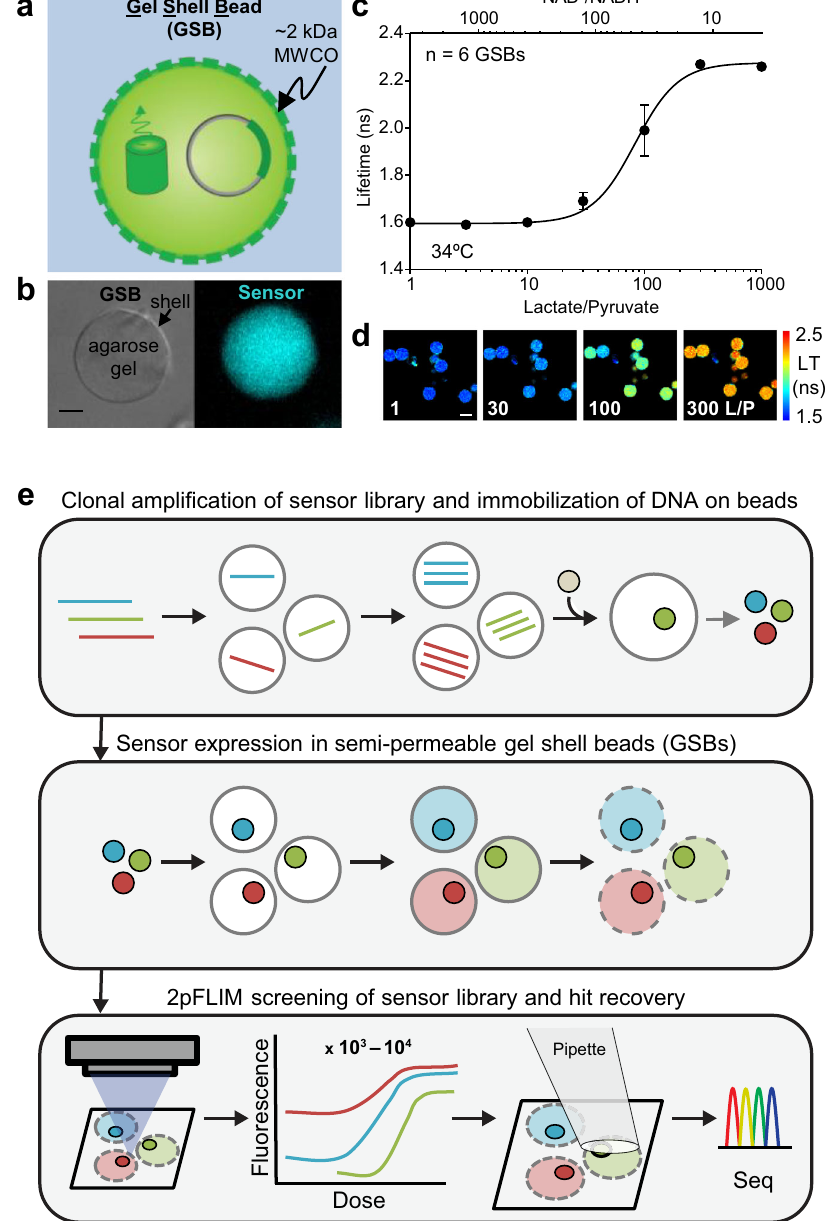
Fig. 1 GSBs as a platform for screening genetically encoded fl uorescent biosensors. a Cartoon depiction of a GSB containing plasmid DNA and fl uorescent biosensor protein. An agarose gel core is wrapped in a polyelectrolyte shell with a reported molecular weight cutoff of ~2kDa 17 . b A single 20 μ m GSB doped with a green fl uorescent biosensor, bright fi eld ( left ) and epi fl uorescence ( right ), 5 μ m scale bar. c Dose response curve of Peredox, a fl uorescence lifetime sensor that responds to NAD + /NADH 1,47 , acquired at pH 7.3 at 34°C on puri fi ed biosensor protein encapsulated in GSBs (mean± SD). Puri fi ed lactate dehydrogenase (LDH) plus lactate and pyruvate was used to set the NAD + /NADH ratio outside the GSBs, following methods previously established for Peredox 47 . LDH does not enter the GSBs. d Filmstrip of the fl uorescence lifetime images used to generate the data in ( c ), pseudocolored according to the lifetime heatmap at the right, and arranged in order of Lactate/Pyruvate (L/P). 30 μ m scale bar. e BeadScan overview schematic. Single plasmids from a biosensor library are isolated in micro fl uidic droplets that serve as picoliter-sized reaction chambers for PCR-based ampli fi cation. Clonal amplicons are immobilized on af fi nity beads introduced into each droplet, ultimately yielding a library of clonal DNA beads. Single beads are then re-encapsulated in new droplets containing in vitro transcription/translation (IVTT) reagents for biosensor expression. IVTT droplets containing mature biosensor are then converted into semipermeable gel-shell beads (GSBs). Up to 10,000 GSBs are arrayed on a glass coverslip for automated fl uorescence imaging and analysis. Single GSBs displaying favorable biosensor properties are collected via micropipette, and the genotypes recovered from the DNA bead by PCR and Sanger